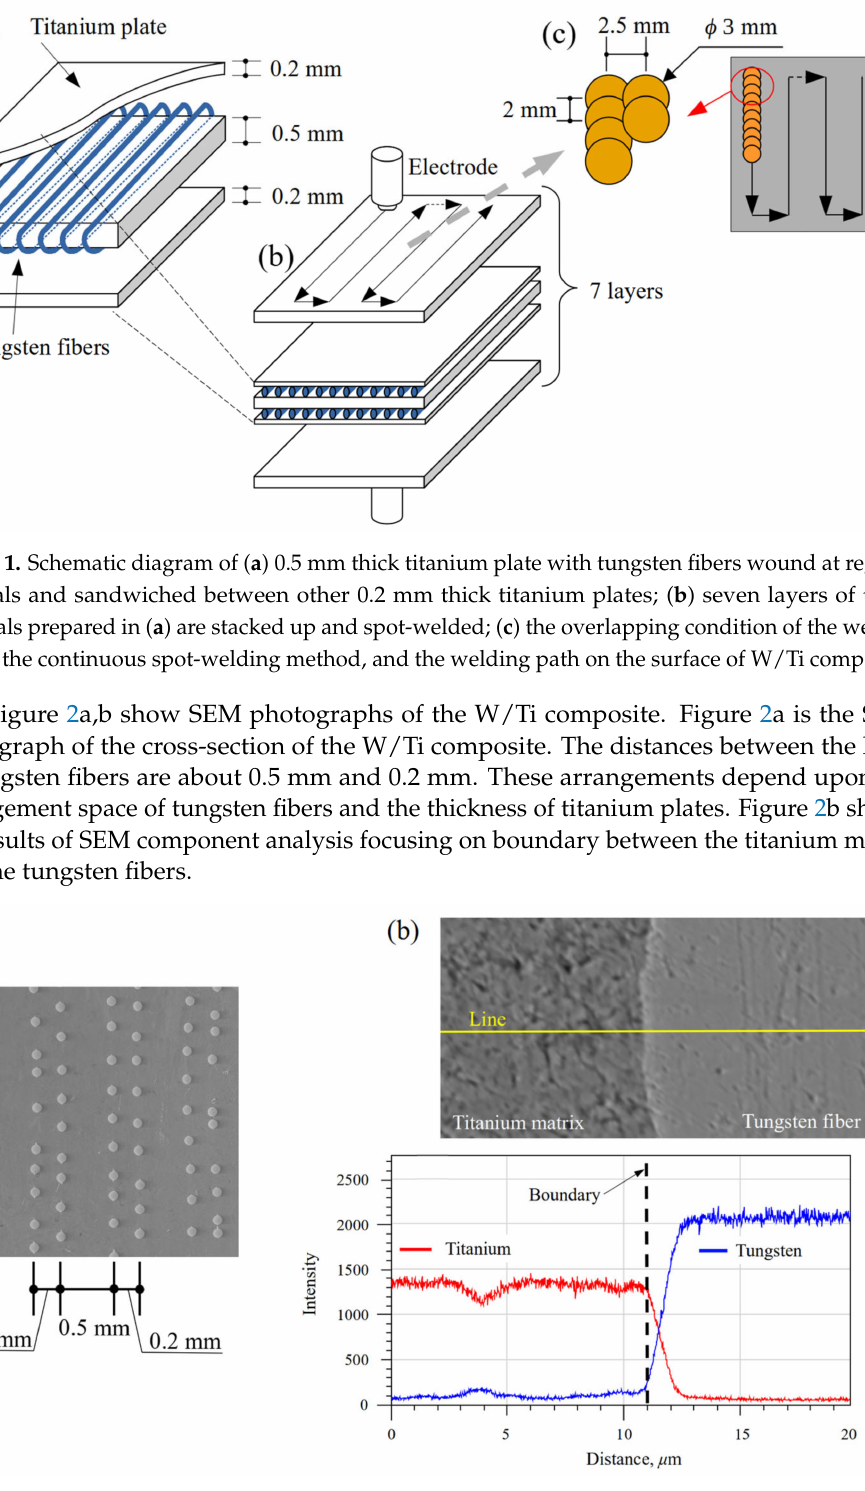
Figure 2. SEM photographs of the W/Ti composite: ( a ) a photograph of the cross-section of the W/Ti composite; ( b ) SEM component analysis focusing on the boundary between the titanium matrix and the tungsten